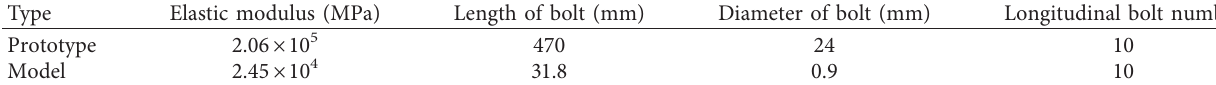
Table 2: The geometric and mechanical properties of model and prototype segmental lining.